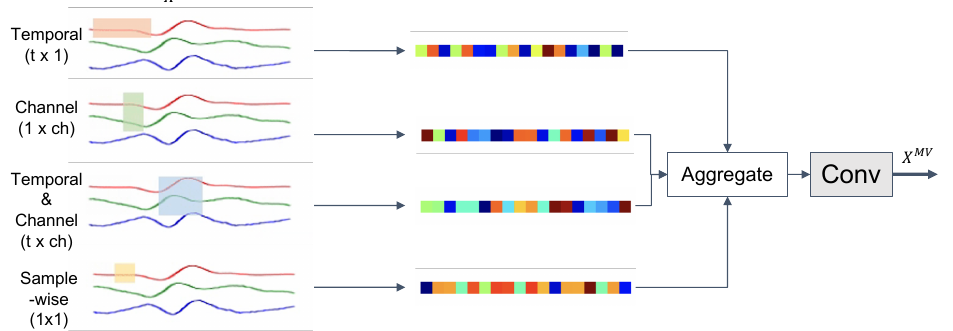
Figure 5. Multi-view convolution (MV-Conv) with kernel shapes t × 1, 1 × c , t × c , and 1 × 1 are used to capture the time and channel correlations. We used different colors for each kernels to show that they are independent and not sharing the weights. Features from each kernel are concatenated along the the feature map axis and recombined through the bottleneck layer. We have explored other feature aggregation approaches, such as summation or bilinear pooling [82], but concatenation was most effective over